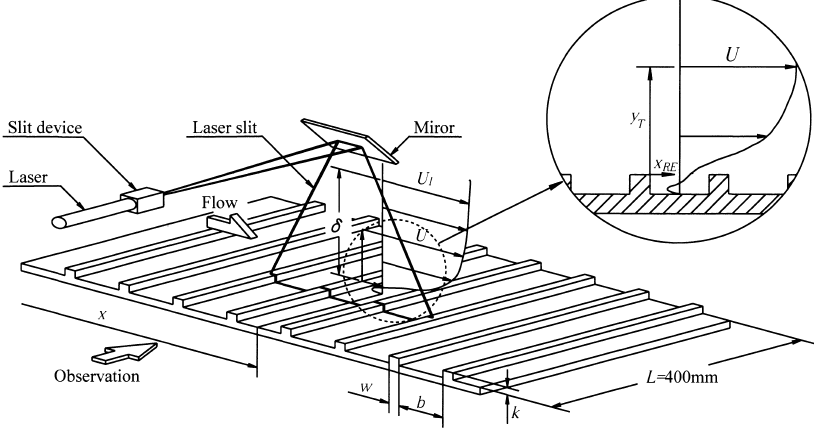
Figure 1 Schematic flow field, coordinate system and